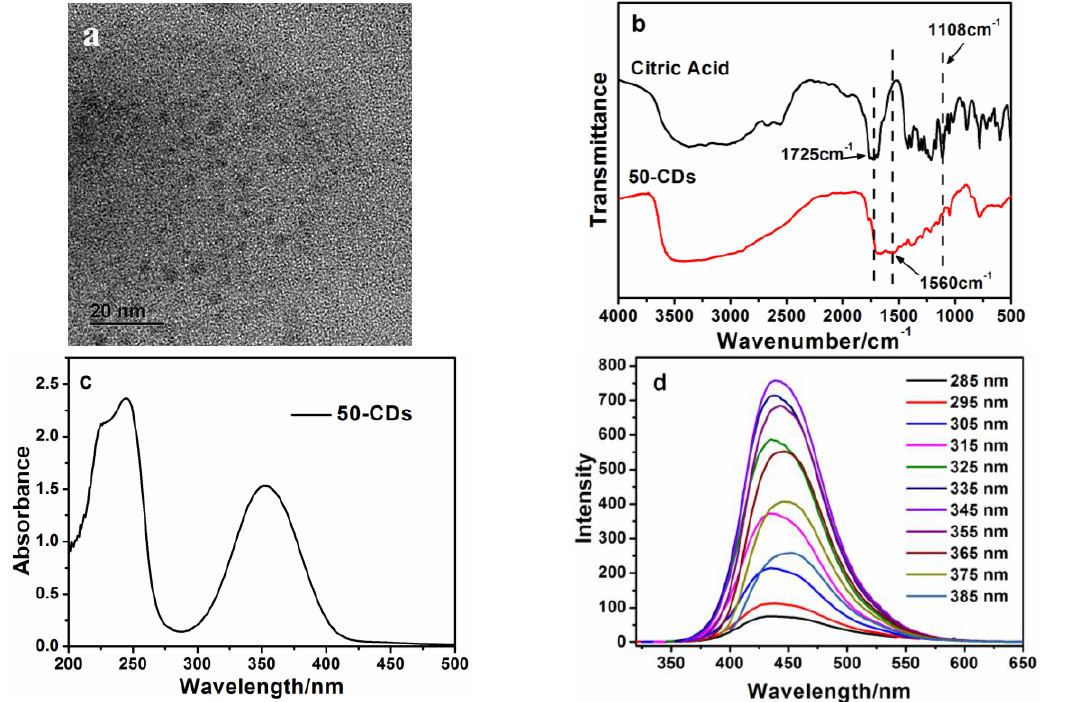
Figure 1. ( a ) Transmission electron microscopy (TEM) of the 50-carbon dots (CDs); ( b ) Fourier transform infrared (FTIR) spectra of citric acid and the 50-CDs; ( c ) Ultraviolet (UV)-visible absorption spectrum of the 50-CDs; ( d ) Photoluminescence (PL) spectra of the 50-CDs at different excitation wavelengths.